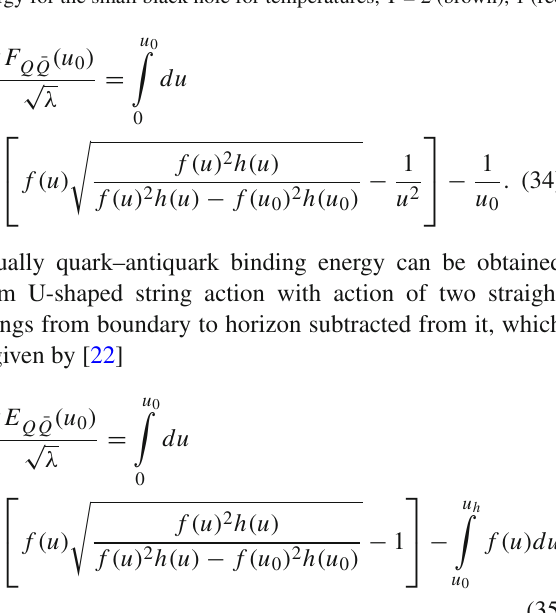
Fig. 10 ¯ a = . 05; a Q ¯ Q binding energy for the large black hole for temperatures, T = 3 (green), 2 (brown), 1 (red), 0.5 (blue), b Q ¯ Q binding energy for the small black hole for temperatures, T = 2 (brown), 1 (red), 0.5 (blue), .01